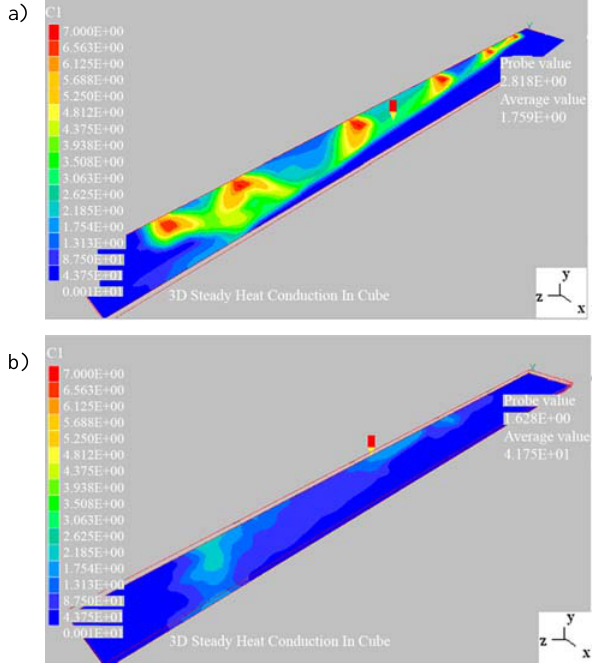
Fig. 8 . Heavy metals spread from outflow in river model: a – river surface; b – river